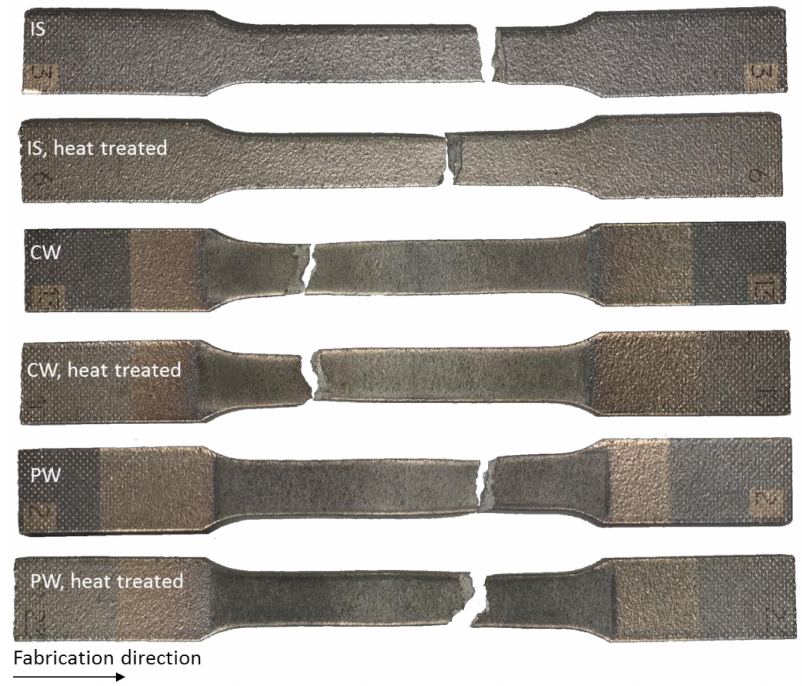
Figure 25. Tensile specimens after tensile